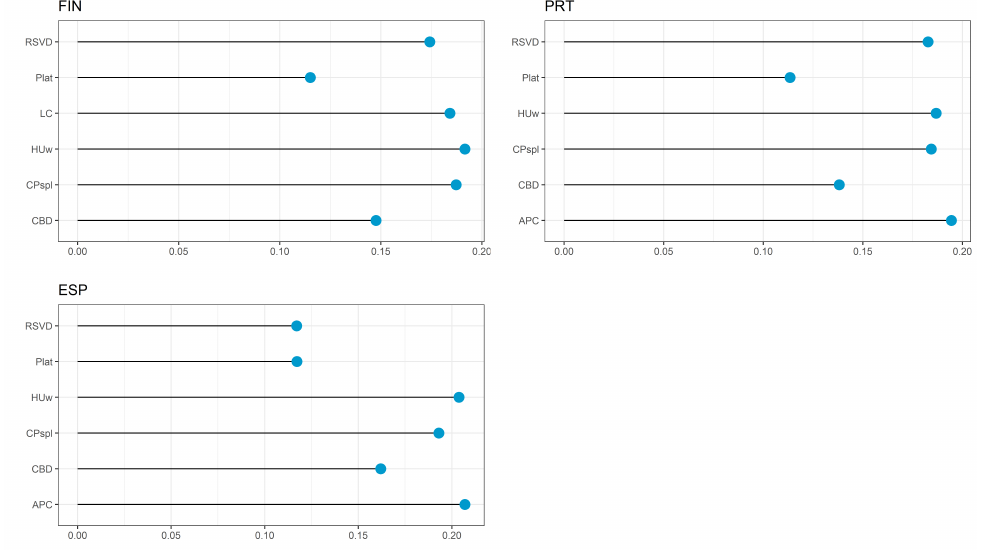
Figure 2. Model confidence set with corresponding model posterior probability. Notes: FIN = Finland, PRT = Portugal; ESP = Spain. The model weights are expressed in percentages and represented in the horizontal